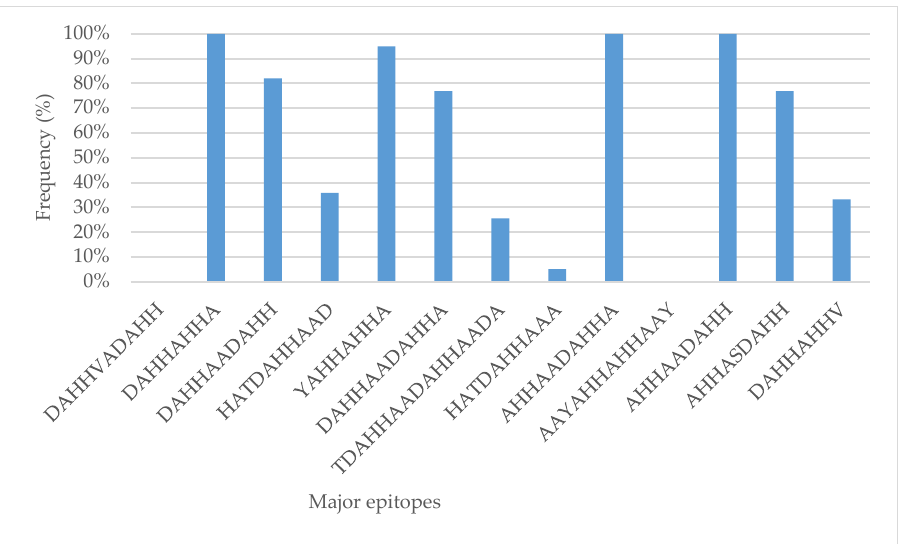
Figure 3. Frequency of P. falciparum HRP2 major epitopes in Tanzania.